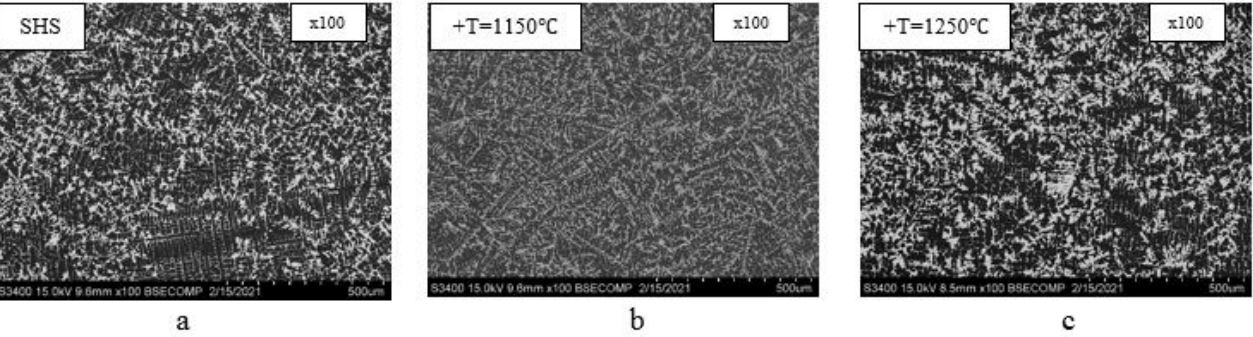
Figure 15. The microstructures of the NiAl–Cr–Co+15%Mo alloy before ( a ) and after annealing at 1150 °C ( b ) and 1250 °C ( c ).